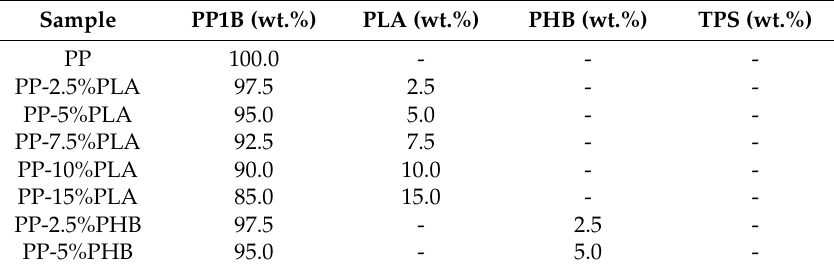
Table 1. Samples